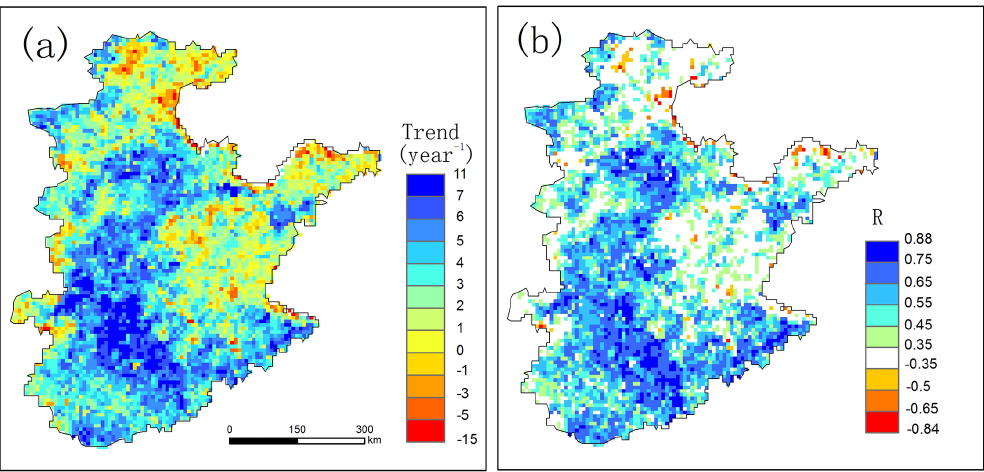
Figure 6. (a) Spatial distribution of the NDVI trends in the growing season and (b) the Pearson coefficients of the NDVI trends above the p <0.05 significance level (the NDVI is scaled by 1000).